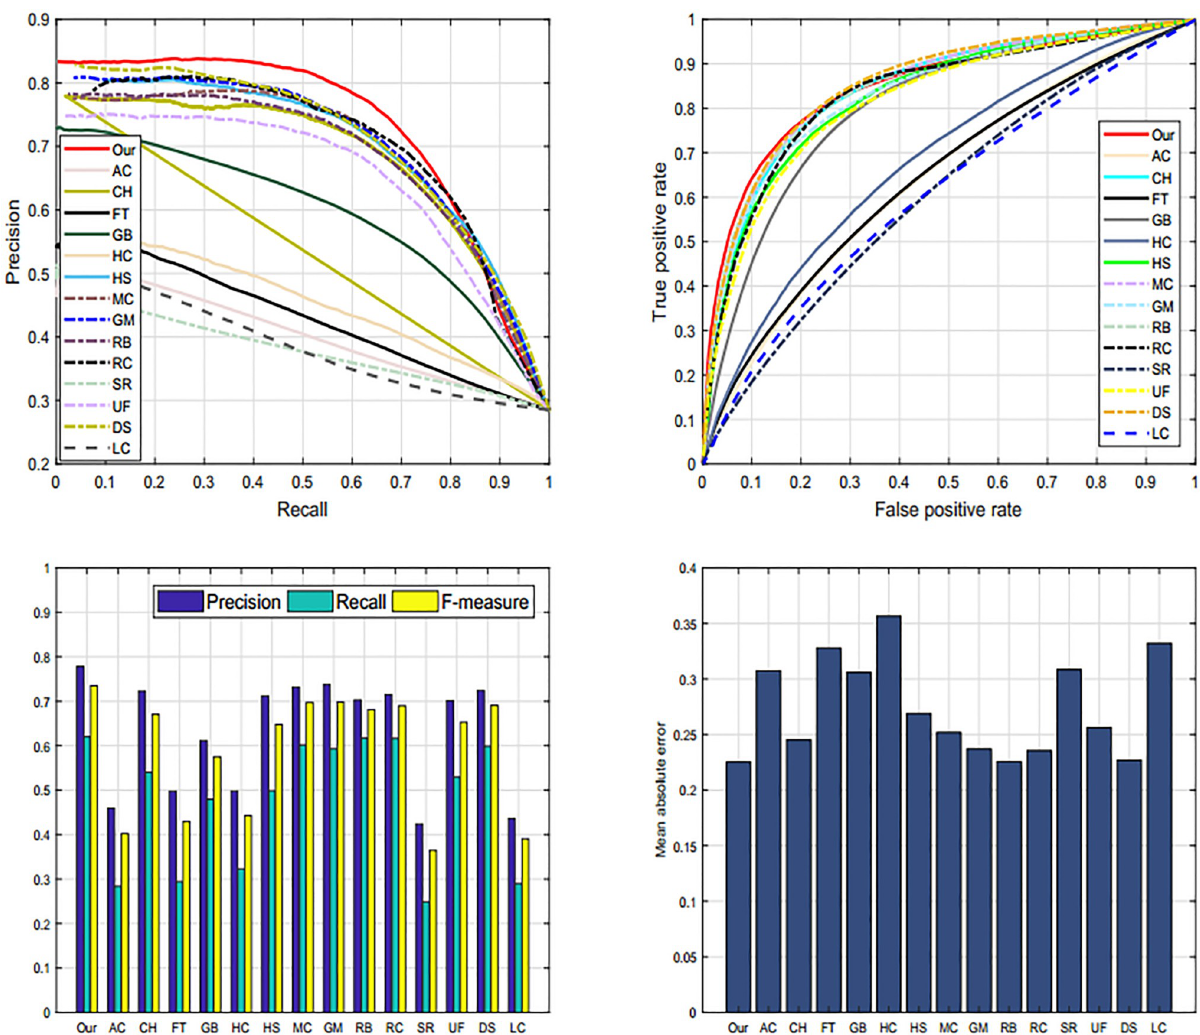
Fig 12. The graphical comparison of proposed model PR-curve, ROC-curve, F-measure, and MAE with existing approaches like: AC [39], CH [44], FT [35], GB [9], HC [10], HS [36], MC [40], GM [5], RB [45], RC [10], SR [43], UF [41], DS [6], and LC [42] on the ECSSD database [36].